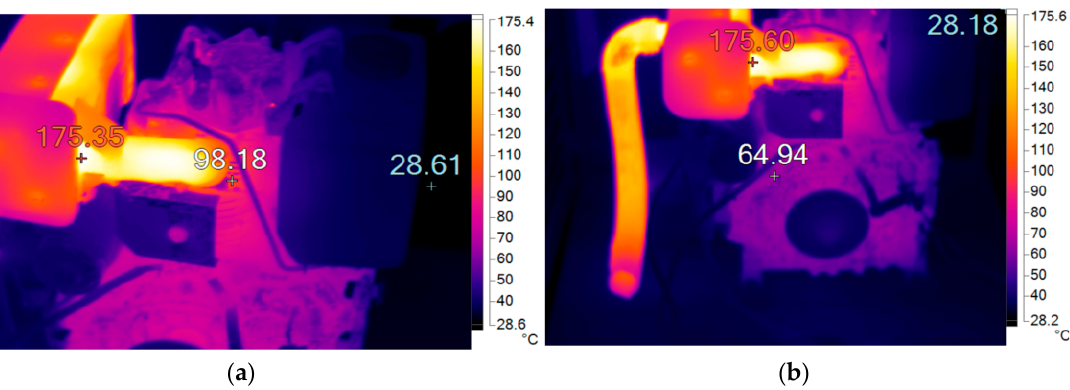
Figure 12. Maximum temperatures in the combustion chamber with the B5 mixture: ( a ) temperature in the chamber of 174.12 °C; ( b) temperature in the chamber of 174.37 °C.